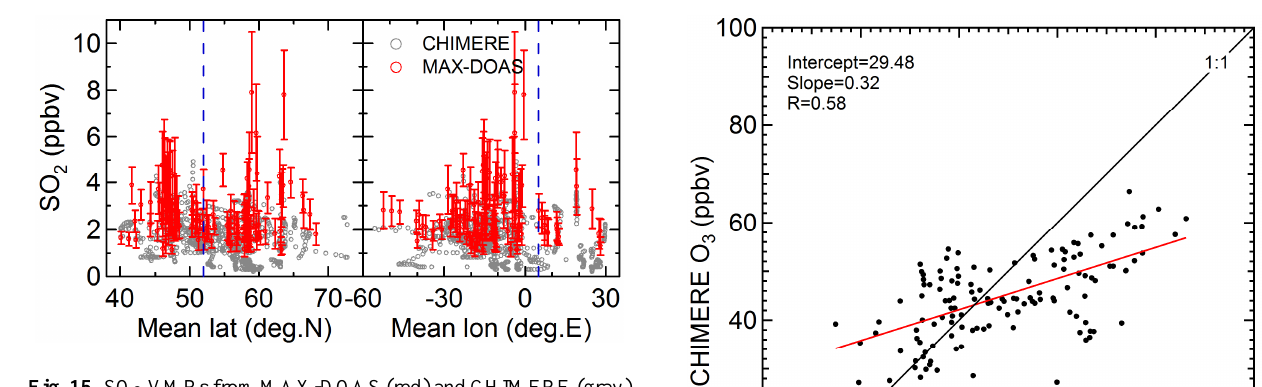
Fig. 14. Examples of back trajectories for air masses that showed (left) low and (right) high SO 2 VMRs at Cabauw on 26 June and 5 July . Colors represent the local time at which the trajectory calculations started.